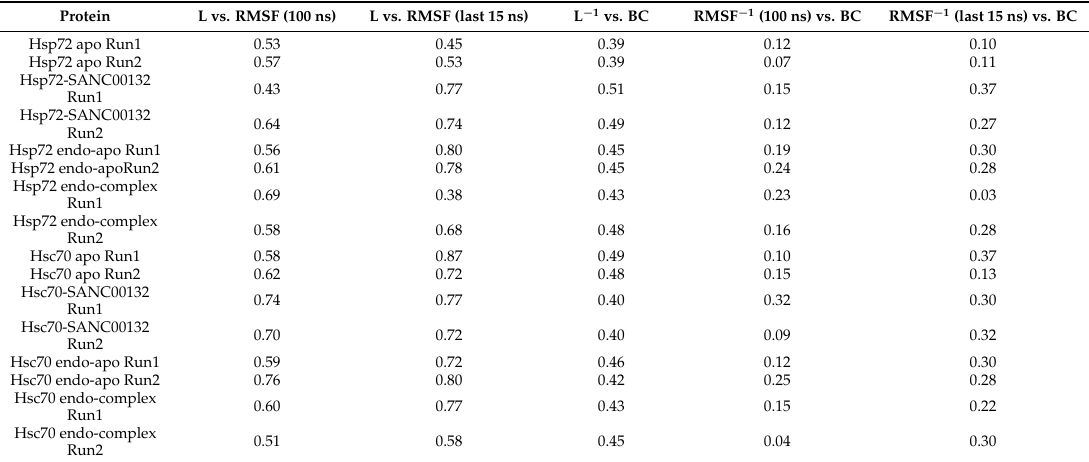
Table 4. Pairwise comparison between BC, L − 1 and RMSF − 1 (100 ns and last 15 ns time frames) using Pearson’s correlation coefficient, apo run1, ( ii